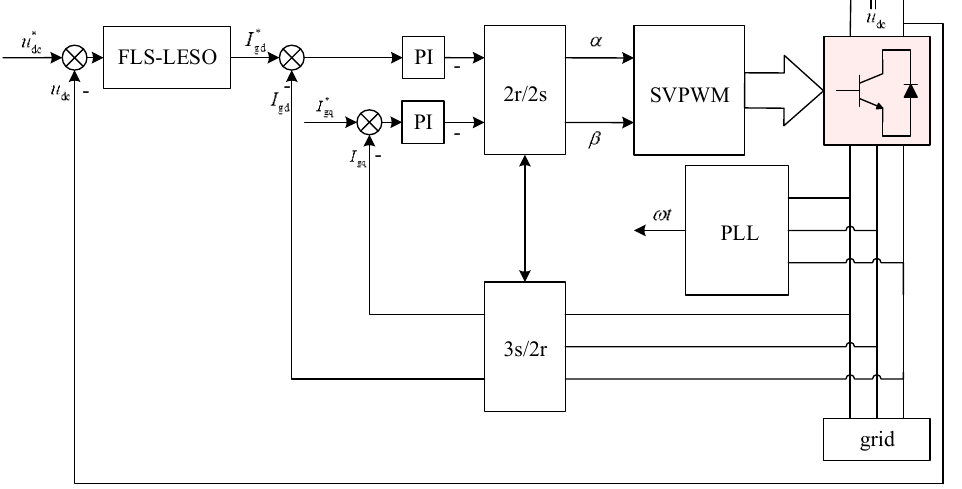
Figure 8. Control system structure.